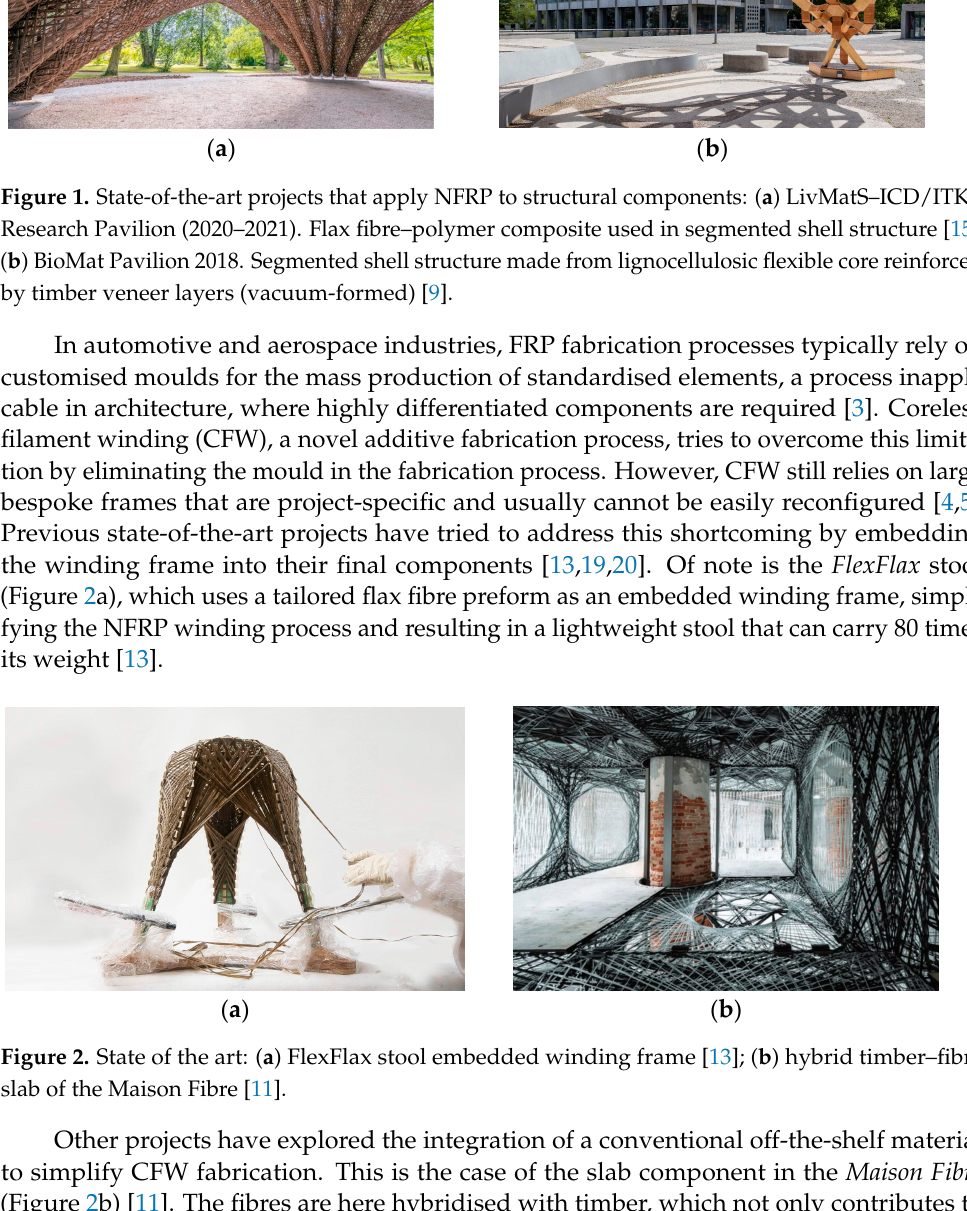
Figure 3. ICD/ITKE Research Pavilion 2015-16: Segmented timber shell and custom lamination of timber veneer to achieve specific bending and strength requirements of architectural shell elements [22]. 2. Materials and Methods 2.1. Materials 2.1.1. Timber Veneer Timber veneer is a thin, bendable, and sometimes brittle material. Its utilisation as a bent winding frame requires staying within its elastic deformation range, without perma- nently warping or snapping it. This involves understanding the bending behaviour, as grain direction varies with respect to the long axis of the element. Figure 4 illustrates how the primary grain direction impacts stiffness or resistance to bending. Along the spectrum ranging from 0 to 90 degrees of the primary grain direction, stiffness decreases as bending flexibility increases. Non-orthogonal grain directions (30, 45, and 60 degrees) result in tor- sional bending.